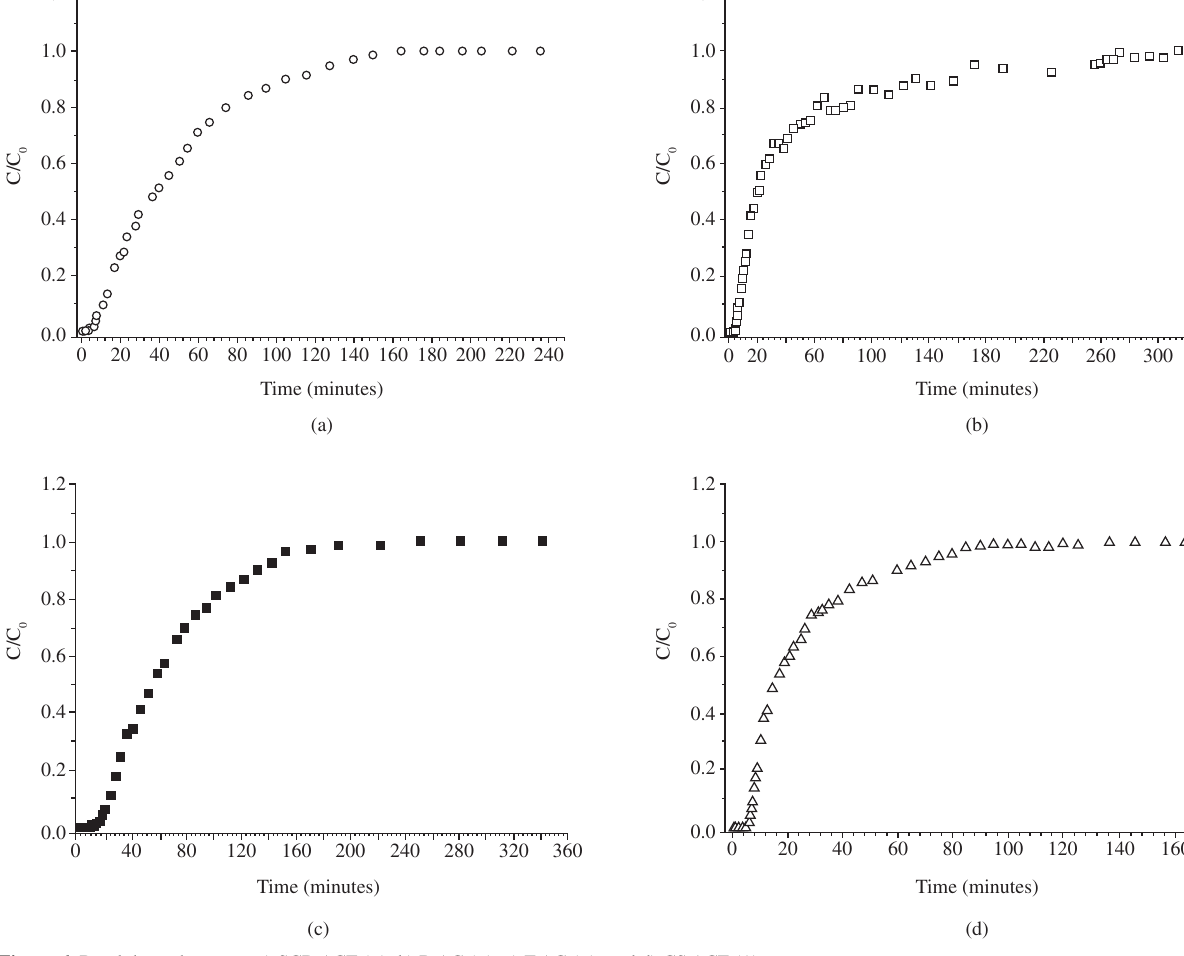
Figure 6. Breakthrough curves: a) SCB ACF ( ○ ), b) B AC ( □ ), c) F AC ( ■ ), and d) CS ACF ( ∆ ).